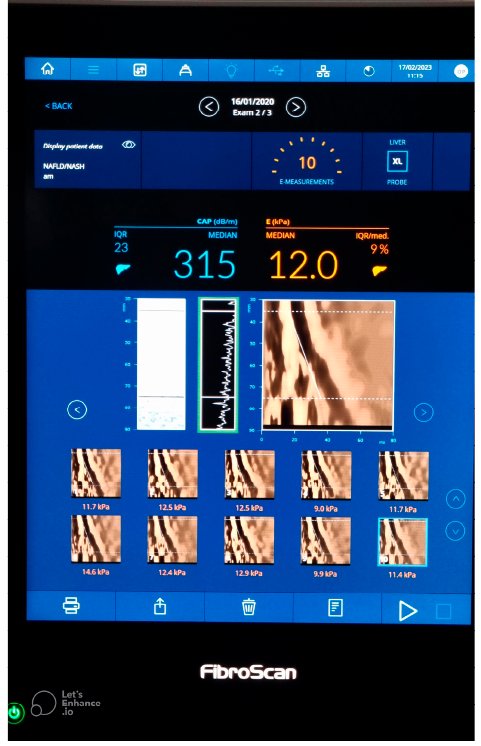
Figure 1. Vibration ‐ controlled transient elastography